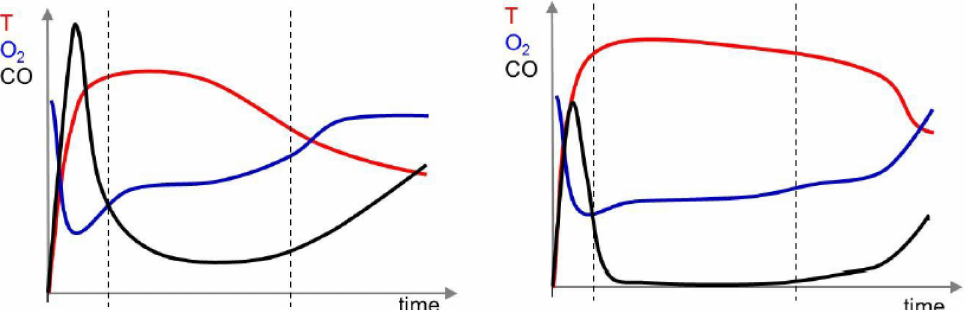
Figure 7. Illustration of a fuel batch of a conventional uncontrolled stove (left) and an automatically controlled stove (right) [48]. Reprint with permission from J. Illerup, C. Mandl, I. Obernberger, R. Mack, H. Hartmann, I. Schüssler, J. Furborg, F. Volz, Guidelines for automated control systems